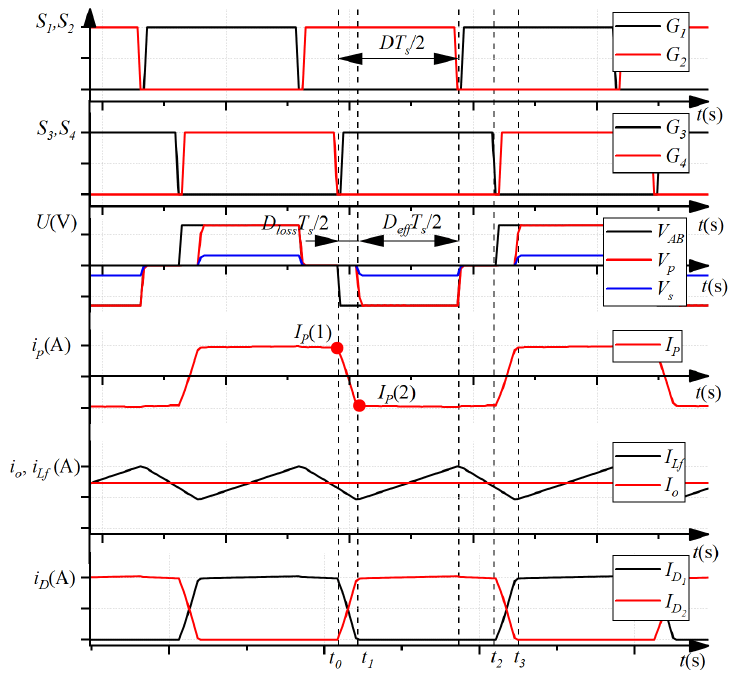
Figure 1. Switching singles and key waveform of PSFB.